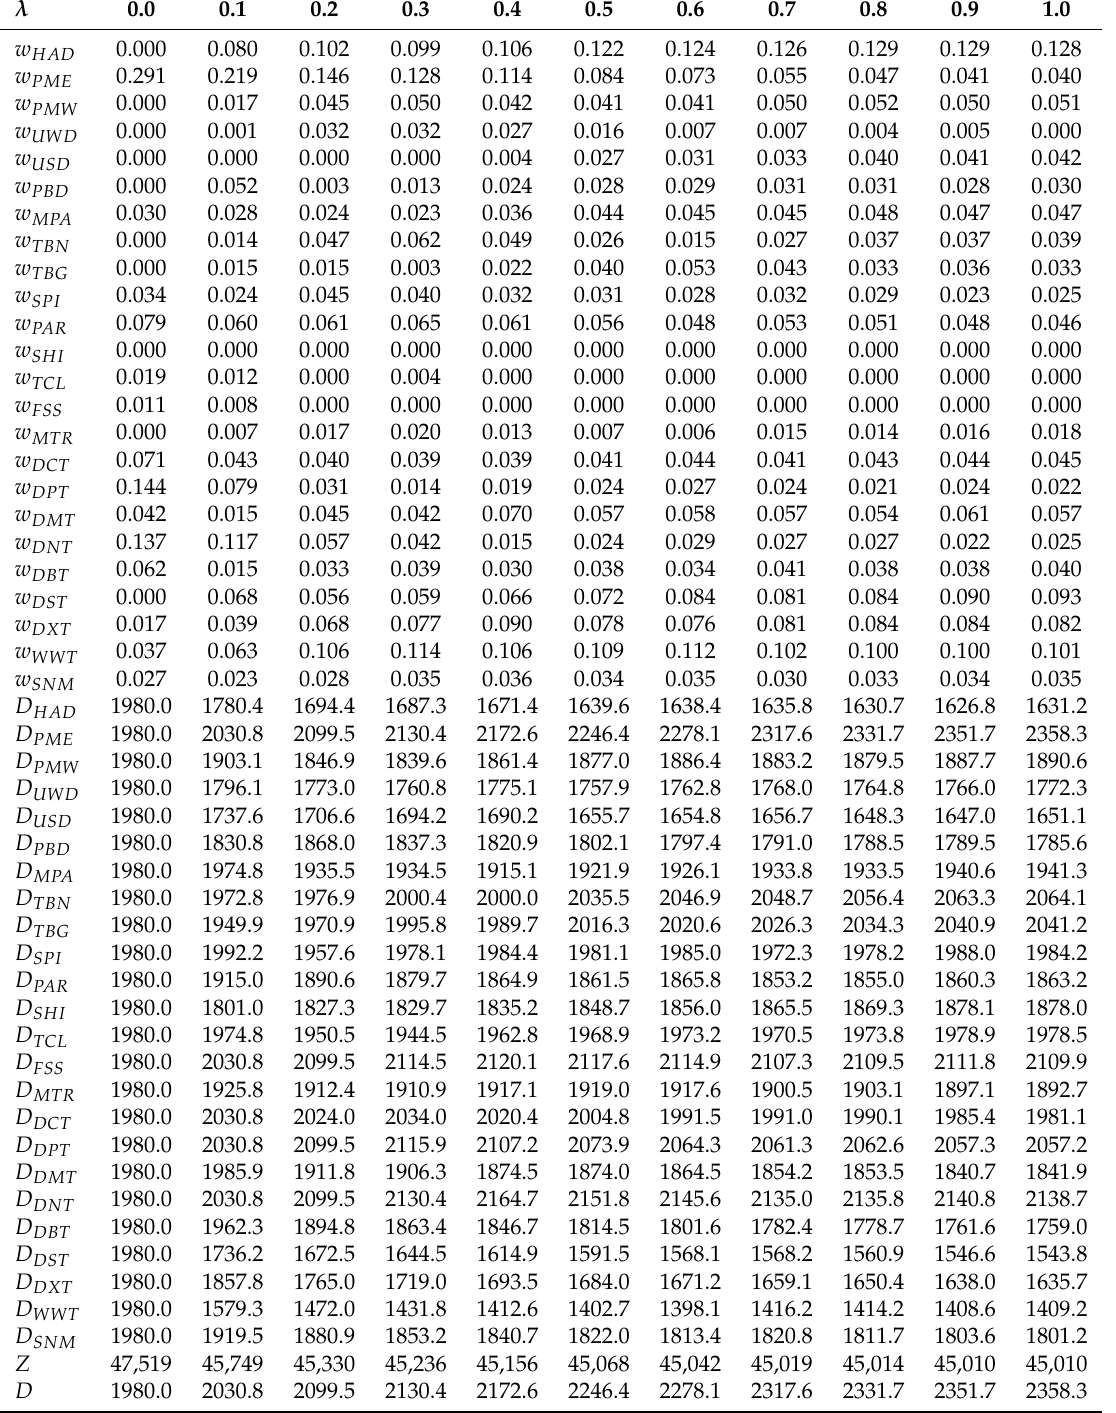
Table 3. Results obtained of the goal programming model for different λ